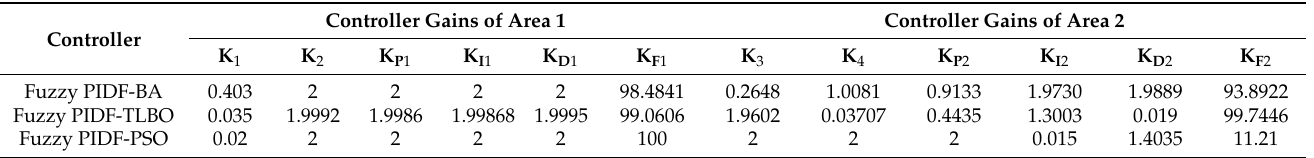
Table 4. Gains of Fuzzy PIDF controllers tuned by BA, TLBO, and